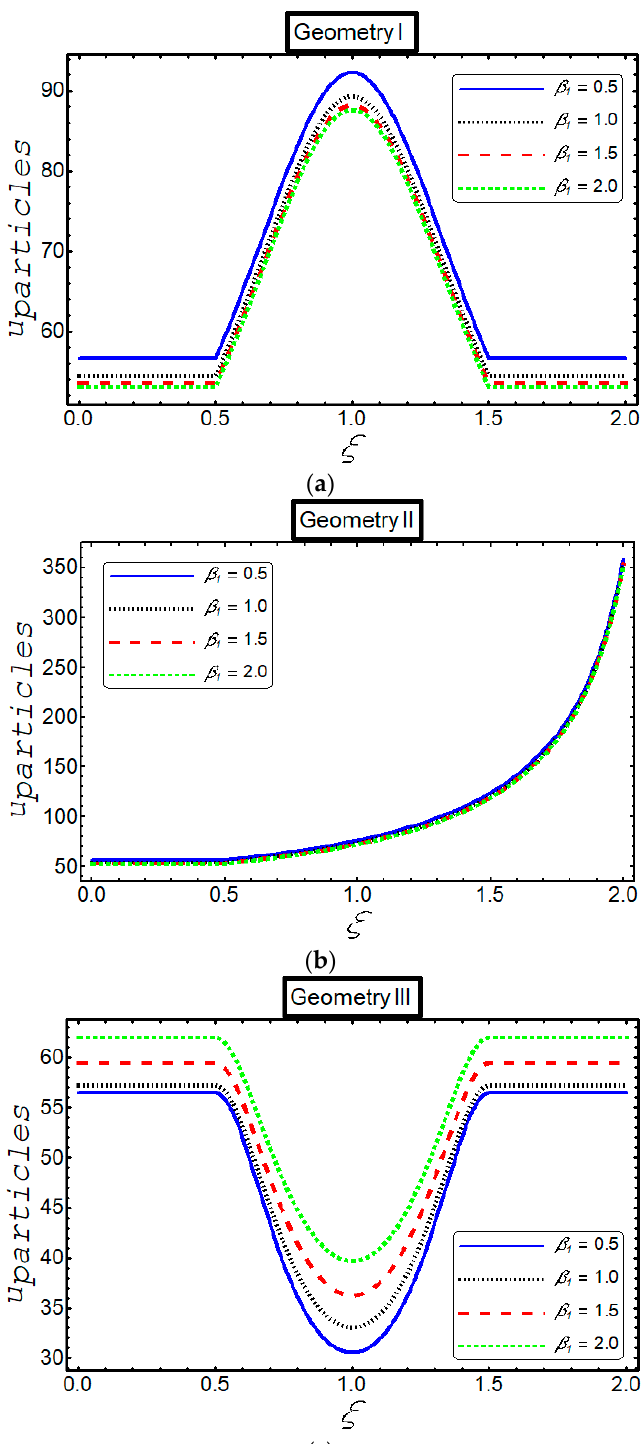
Figure 11. Velocity variation for slip parameter β 1